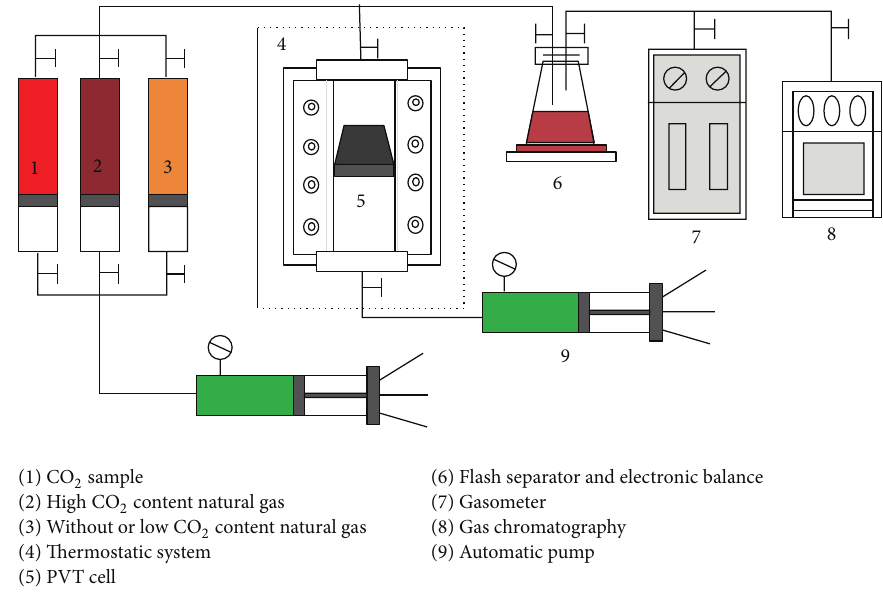
Figure 4: Schematic diagram of the experimental apparatus. Table 3: Results from two-flash experiments for different CO